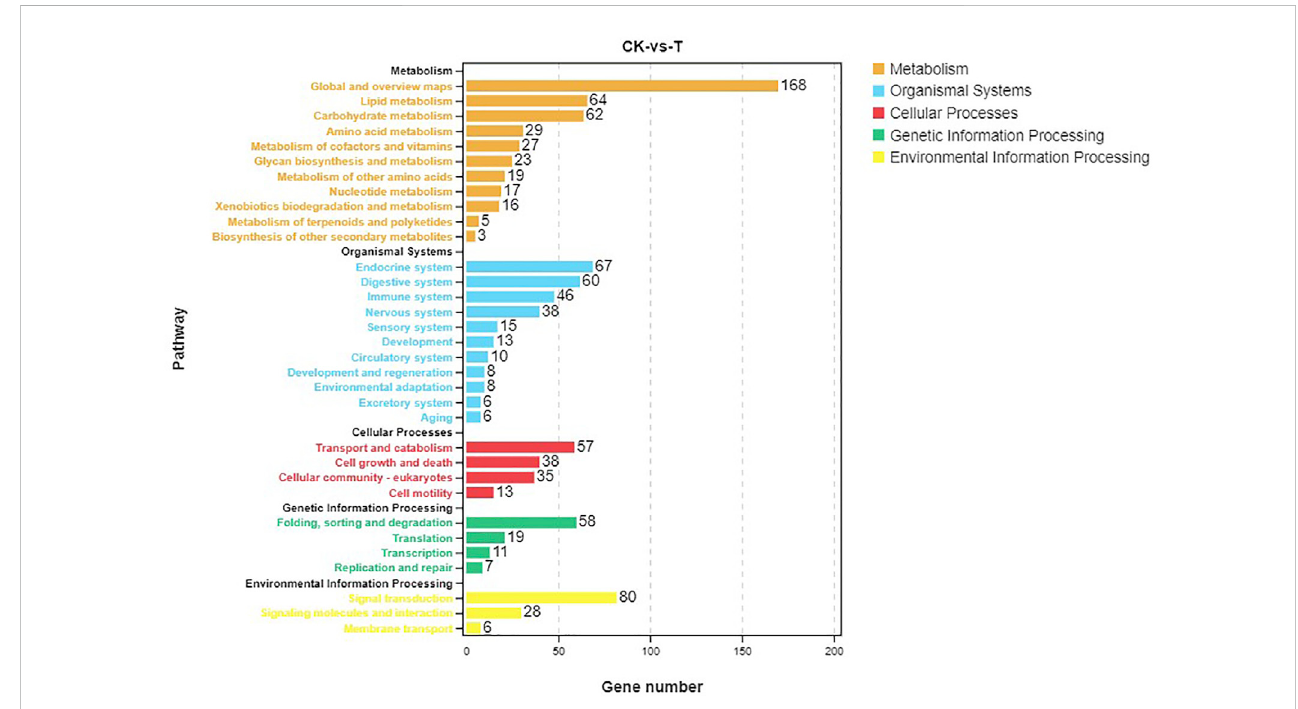
Pathway analysis based on